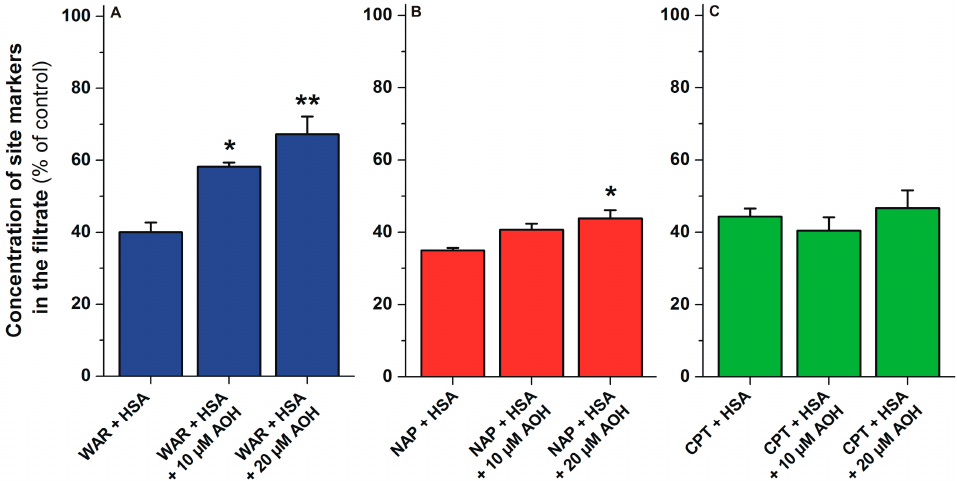
Figure 7. Displacement of Sudlow’s site I (SSI) (WAR, warfarin), Sudlow’s site II (SSII) (NAP, naproxen), and Heme site (CPT, S-camptothecin) ligands from HSA by AOH. Concentrations of warfarin ( A ), naproxen ( B ) and S-camptothecin ( C ) in the filtrates (% of control): Before the ultrafiltration, samples contained WAR and HSA (1.0 and 5.0 µ M, respectively), NAP and HSA (1.0 and 1.5 µ M, respectively), or CPT and HSA (1.0 and 1.5 µ M, respectively) with or without 10 or 20 µ M AOH in PBS (pH 7.4; * p < 0.05, ** p < 0.01). In each model, the filtered concentration of site markers was compared to the concentration measured in the filtrate when no HSA was added to the sample